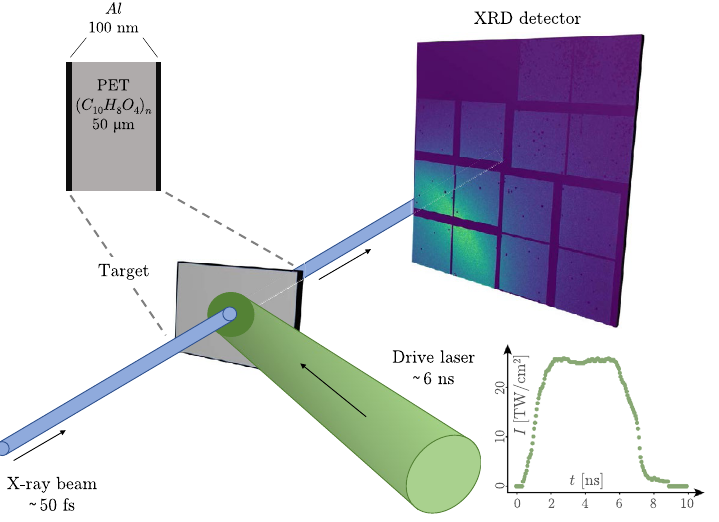
Figure 1. Experimental setup for the XRD measurements. A PET foil was shock-compressed using a 6 ns (FWHM) optical laser pulse. Structural changes were probed by the 8.1 keV LCLS X-ray beam via in situ XRD. The resulting diffraction image has been recorded using a single-photon-sensitive area